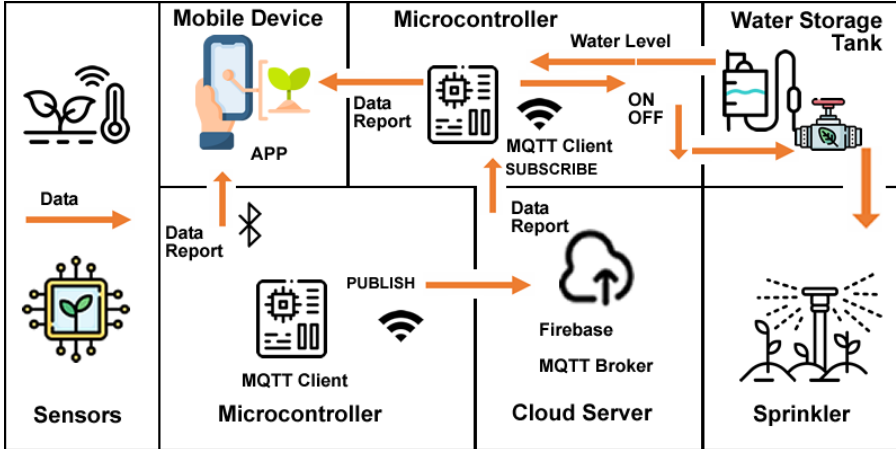
Figure 12. SmartGreen System Architecture.